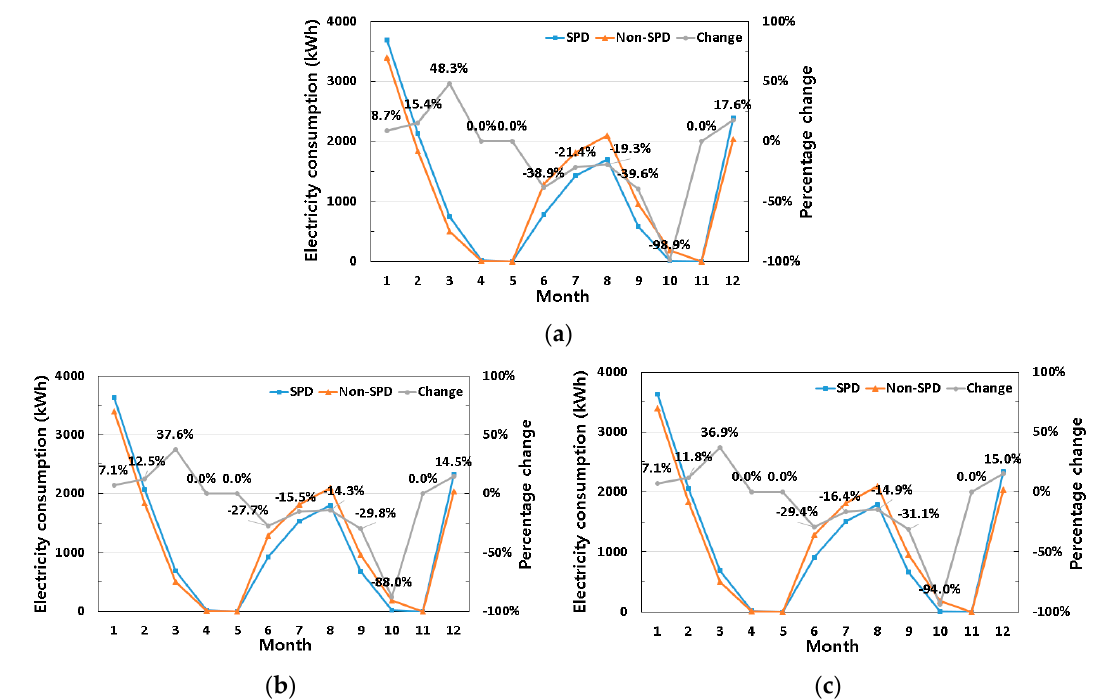
Figure 12. Electricity consumption of SPD / non-SPD models and variation compared to non-SPD model according to the orientation of SPD windows: ( a ) south, west, and east (SWE); ( b ) south, east, and north (SEN); ( c ) south, west, and north